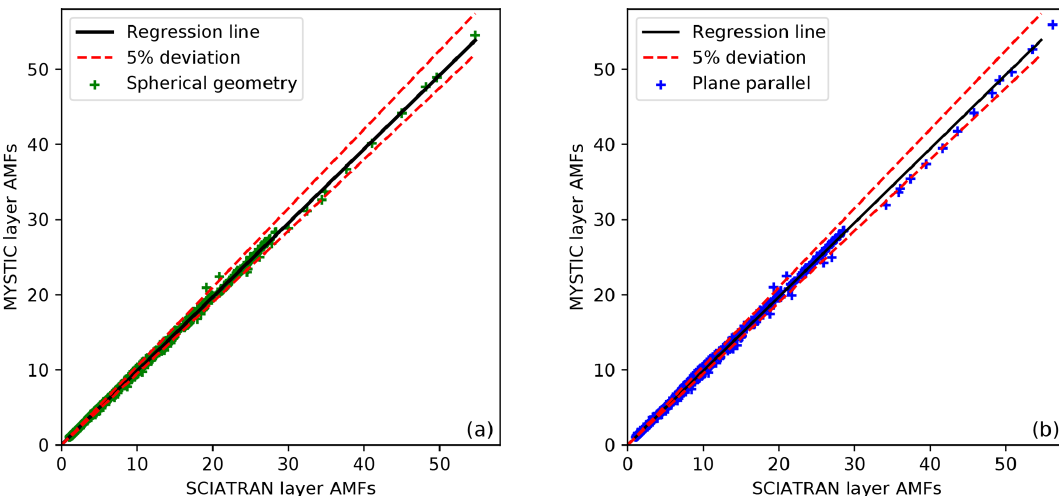
Figure 2. Scatter plots of MYSTIC 1D-layer AMFs computed with (a) spherical and (b) plane-parallel geometries against 1D-layer AMFs computed with SCIATRAN (a) spherical and (b) plane parallel for 67 MAX-DOAS scenarios with 17 layers (1139 points). The solid black lines are the respective regression fits to the points.